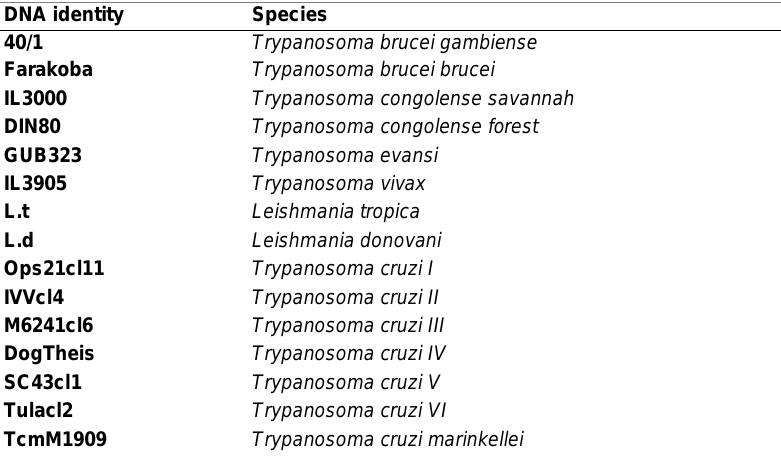
Table 3: DNA identity and Trypanosomatidae species used to evaluate the specificity of the